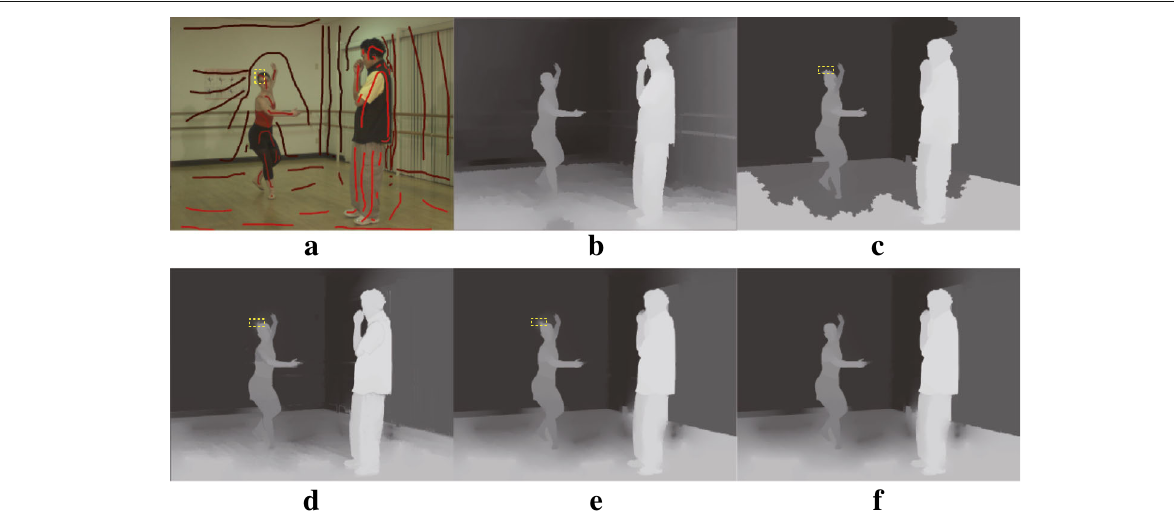
Fig. 1 Depth estimation with cross-boundary user input (depth artifacts caused by cross-boundary scribbles are marked by yellow rectangles). a Input image with user scribbles (the cross-boundary scribble is marked by the yellow rectangle). b Groundtruth. c Hybrid GC and RW [18]. d Nonlocal RW [22]. e Optimization [24]. f Proposed. Please zoom in to see